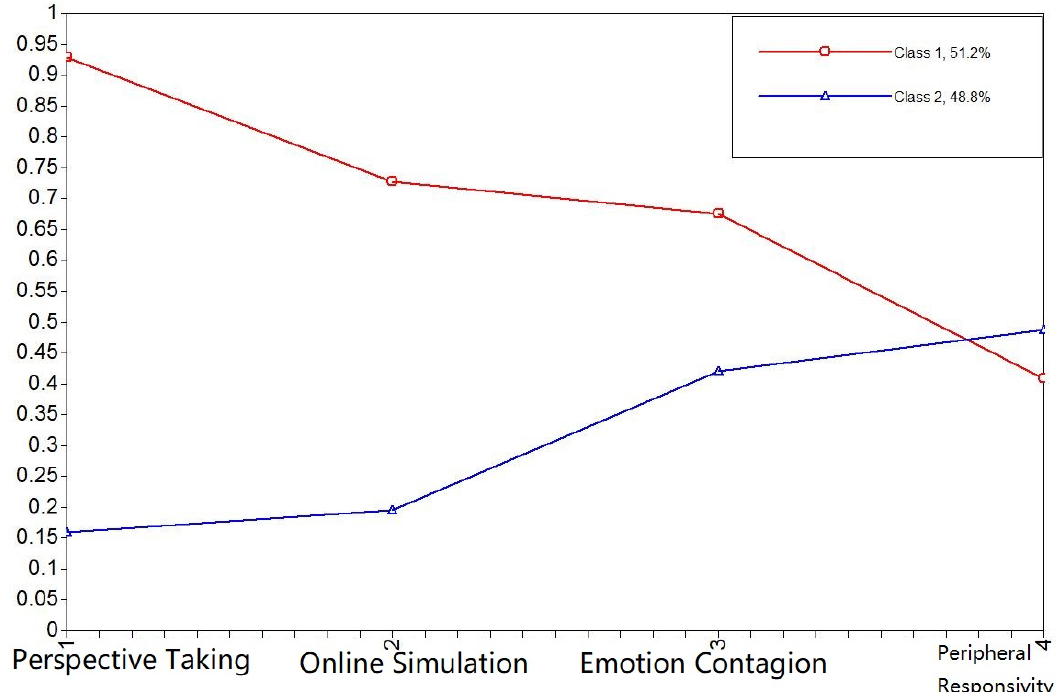
Figure 7. Plot of class-specific response probabilities for each of four subscales of Empathy for the Chinese in China.